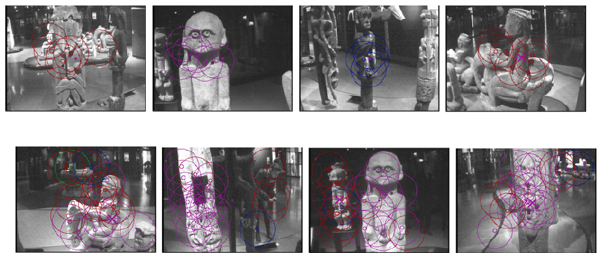
Figure 6: (Top) represents the learning mode, local views associ- ated with the emotional value. (Bottom) represents the test mode, Berenson associates the recognized object to the learned emotional value. Here the images are taken from the same test but with differ- ent number of local views (8 were extracted in learning mode and 20 in test mode), the cercle’s color represents the emotional